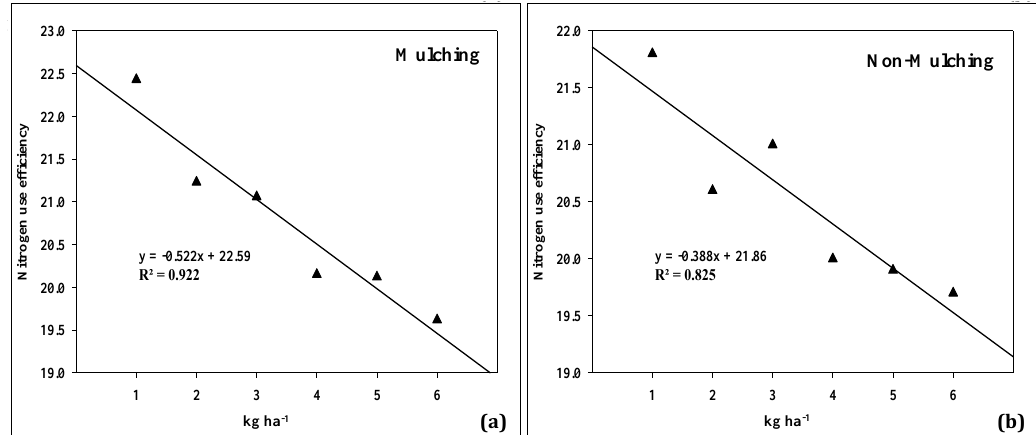
Figure 7. Relationship between nitrogen application rates and Rh inoculation (1 = 50% RDN (12.5 kg ha −1 ); 2 = 50% RDN (12.5 kg ha −1 ) + Rh ; 3 = 75% RDN (18.75 kg ha −1 ); 4 = 75% RDN (18.75 kg ha −1 ) + Rh ; 5 = 100% RDN (25 kg ha −1 ); 6 = 100% RDN (25 kg ha −1 ) + Rh ) and nitrogen use efficiency in peanut under mulched ( a ) and nonmulched ( b ) treatments in 2015–2016.